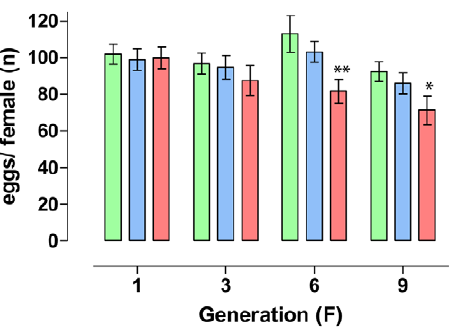
Figure 5. Eggs viability – selected lineages. Egg viability of Ae. aegypti during deltamethrin selection in the laboratory. Mean egg hatching rate and standard error are represented. Lines are regression of Rock and the pooled S and R lineages. Values for linear regression analysis are: Rock ( b = 2 0.1644, r2=0.2748, p . 0.05), S ( b = 2 0.5666, r2=0.5212, p , 0.05) and R ( b = 2 3.854, r2=0.8998, p , 0.0001).